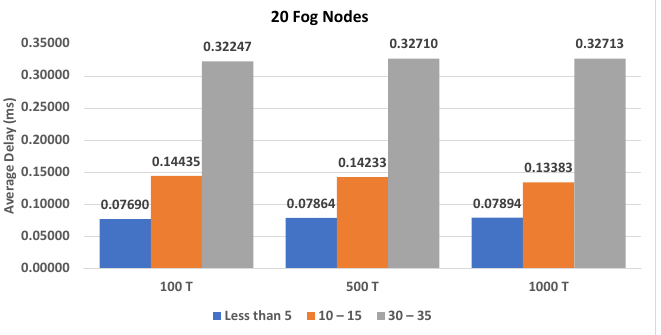
Figure A10. The impact of the different set of affected transactions on twenty fog nodes.